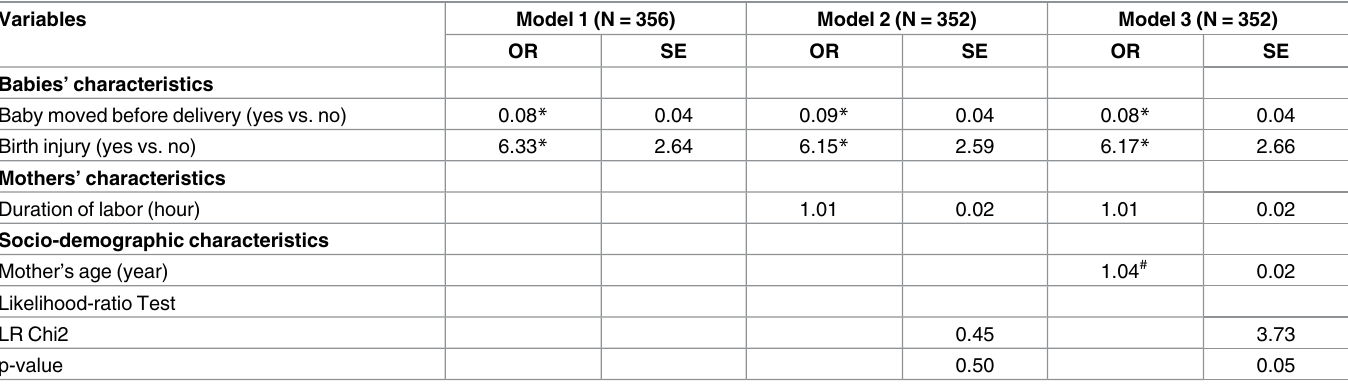
Table 4. Multivariate regression results & . (OR: odds ratio; SE: standard